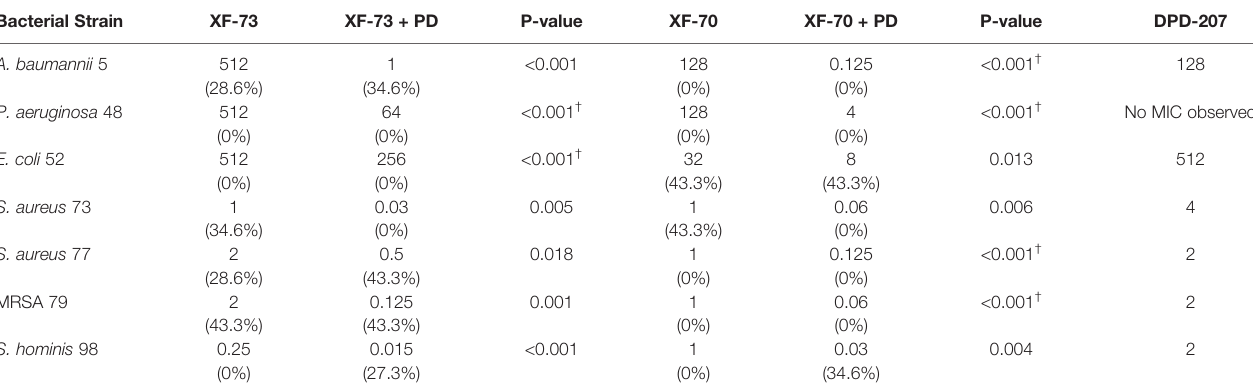
TABLE 1 | Minimum inhibitory concentrations (µg/ml) of XF drugs to selected bacteria. Bacterial